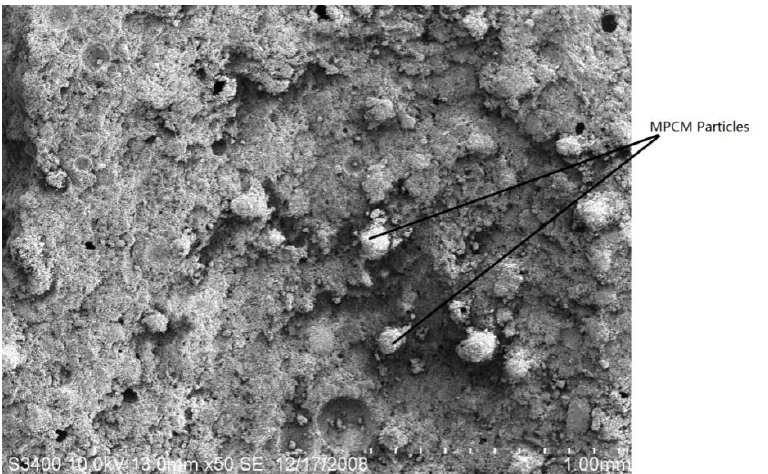
Figure 6. Microstructure of hardened cement paste with